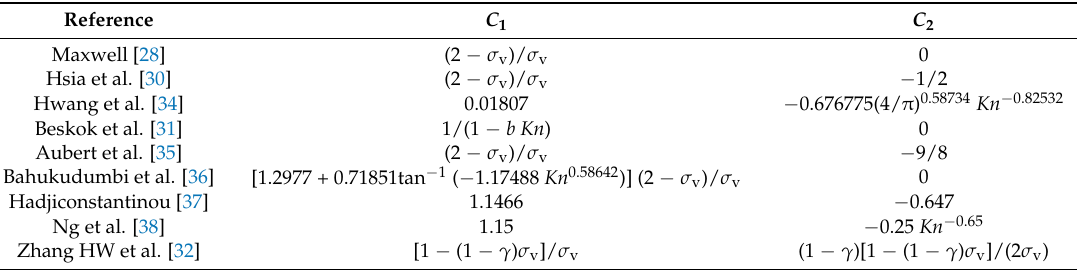
Table 1. Slip coefficients in different slip boundary